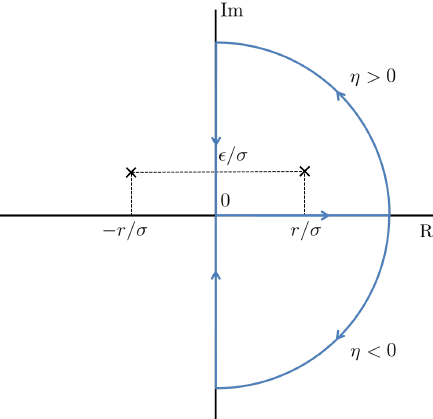
Figure A1. The contour of the complex integration to compute the non-diagonal component X ∗